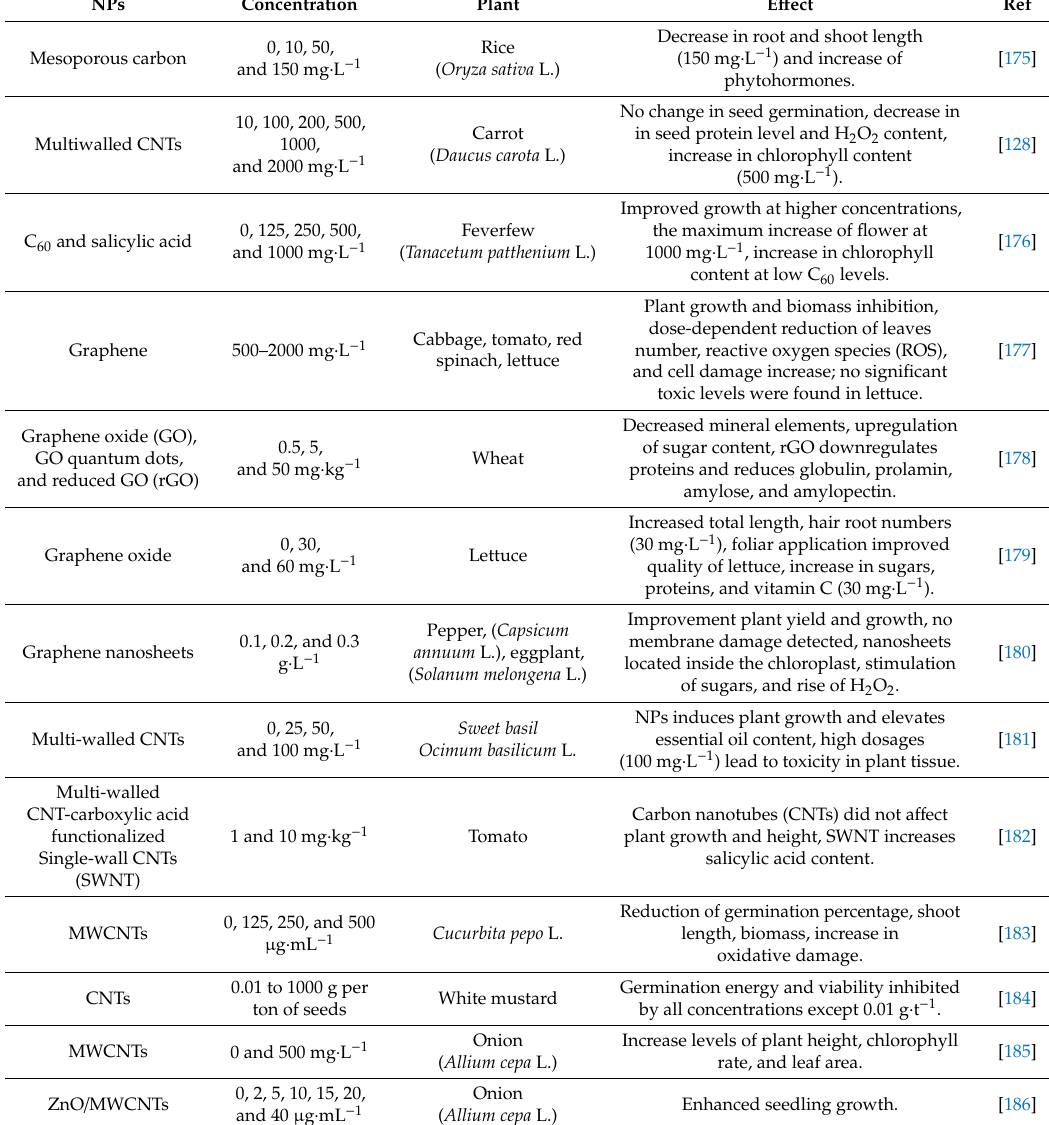
Table 4. E ff ects detected by the interaction of carbon-based nanomaterials over di ff erent